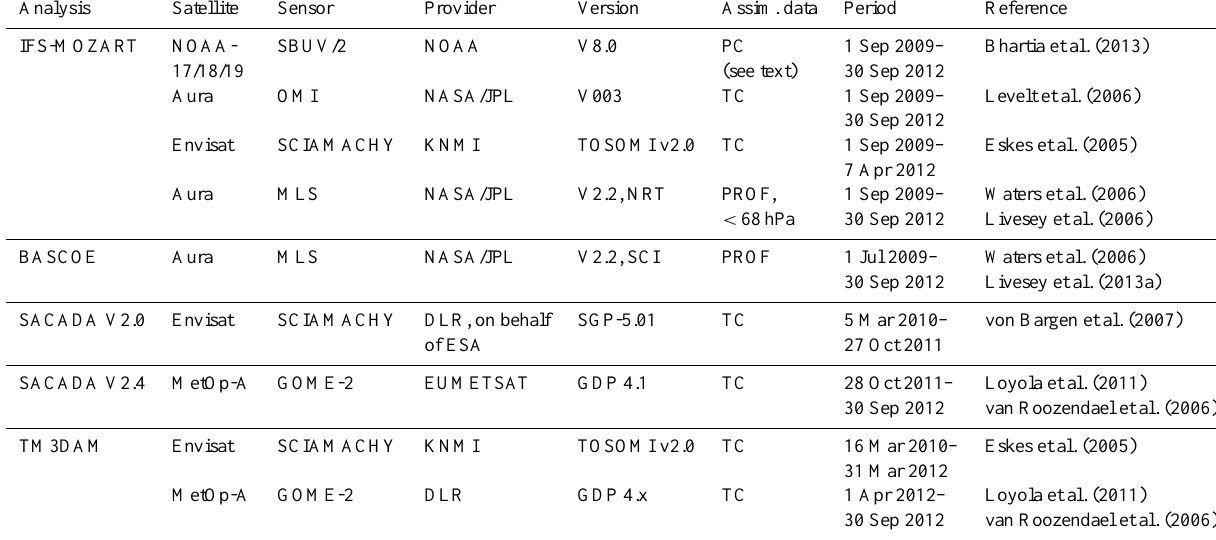
Table 1. Satellite retrievals of ozone that were actively assimilated by the four models of the MACC stratospheric ozone service. The Aura MLS data used by IFS-MOZART and BASCOE are not the same: IFS-MOZART used the MLS NRT retrievals of ozone only, while BASCOE used the standard scientific, offline retrievals including five other species. PC stands for partial columns, TC for total columns and PROF for profiles. When two references are provided, the first refers to the satellite sensor, the second one to the retrieval algorithm.